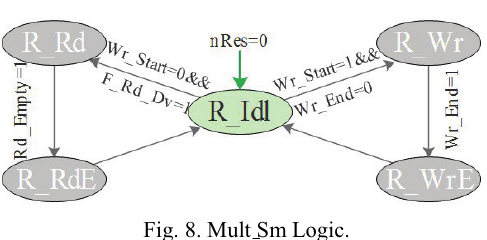
Table 2. I/O Definition of Multiplexer.